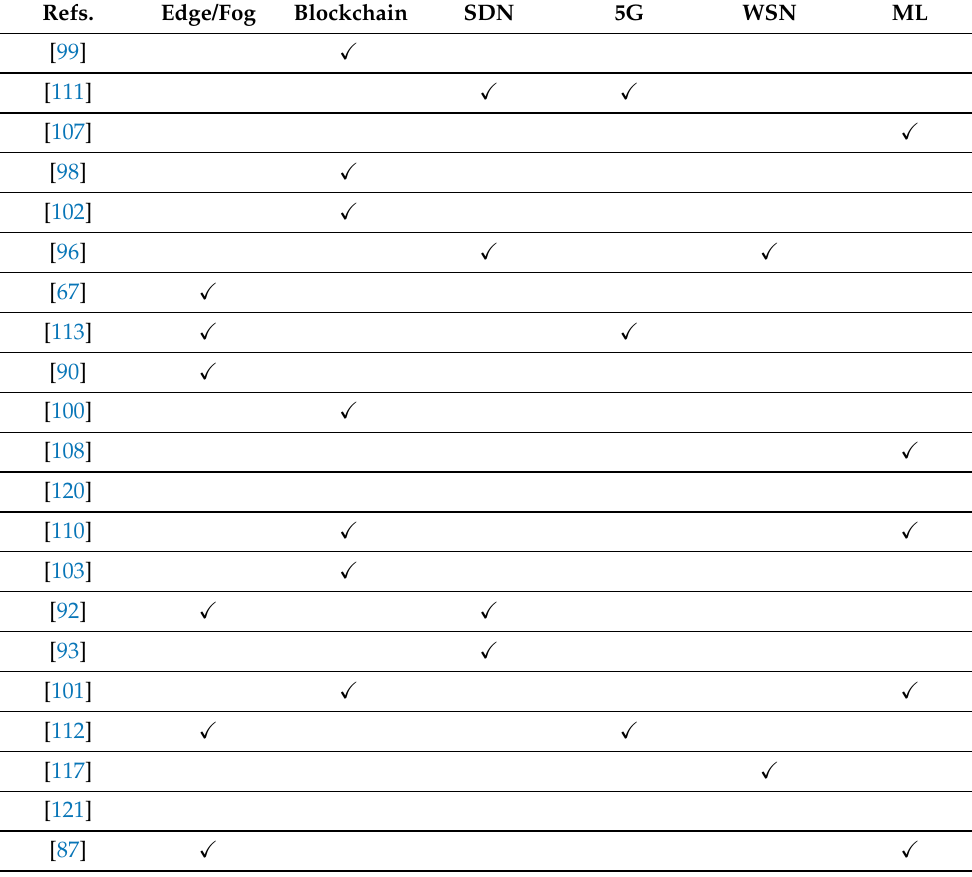
Table 4. Emerging technologies in the literature.